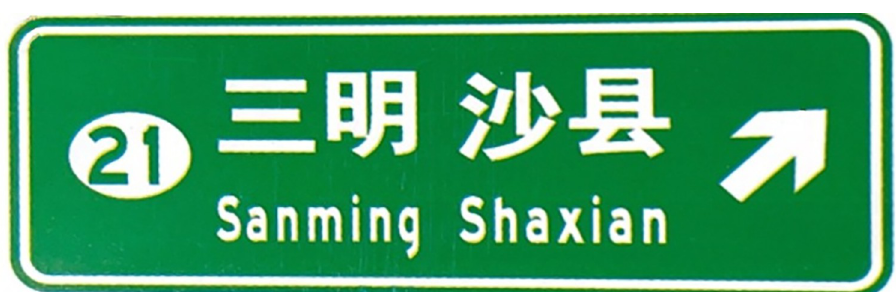
Fig 2. Example of exit advance guide sign in